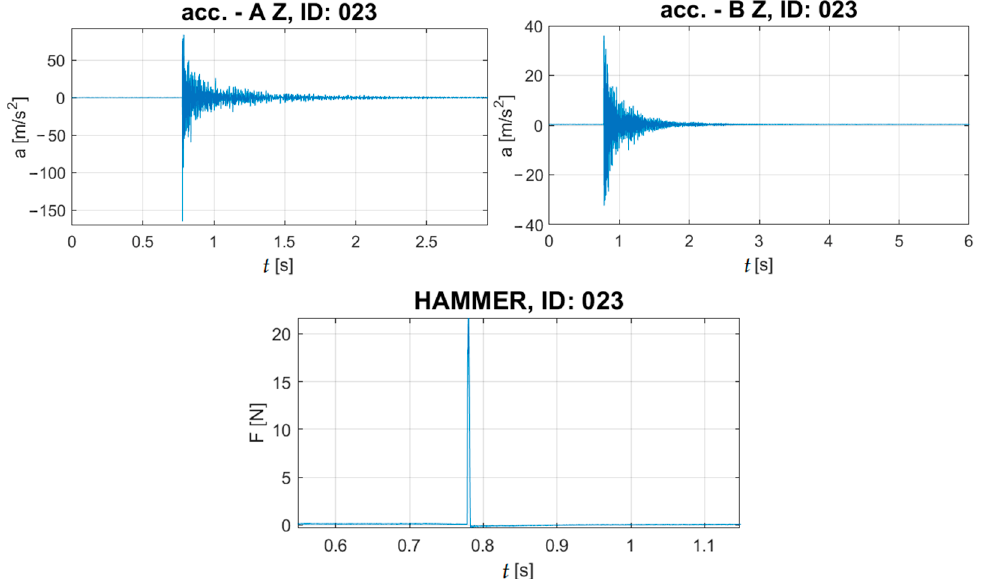
Figure 12. The output signal from the accelerometer and the input signal from the hammer. In an ideal case the impact would be a Dirac-delta excitation, in reality it is finite width and must be free from contact bounce (multiple hit).